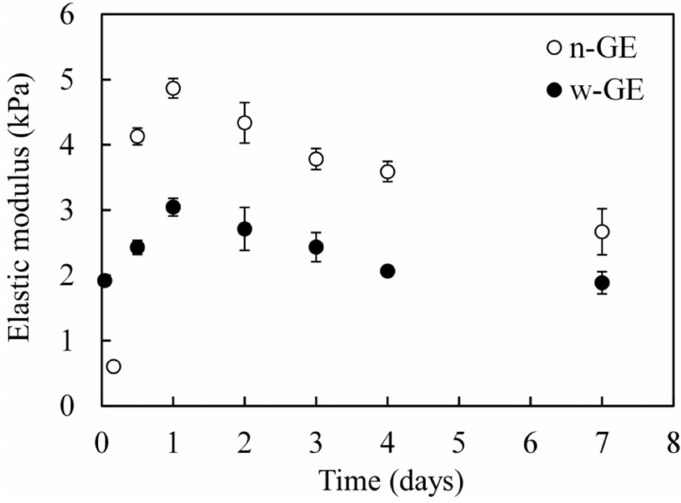
Figure 3. Time-dependent changes of elastic moduli of 0.8% CH/1 mM genipin gels. Data are expressed as mean ± SD ( n = 5).